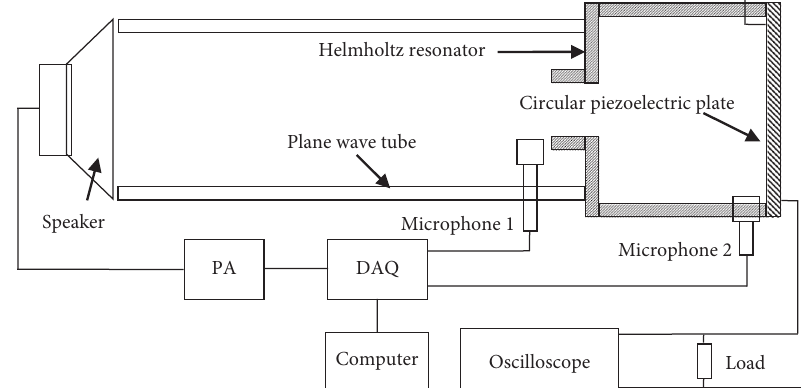
Figure 16: Experiment setup.